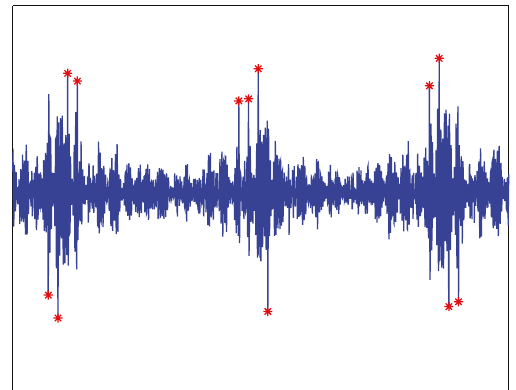
Figure 14: Received signal for M = 16 with the new modulation